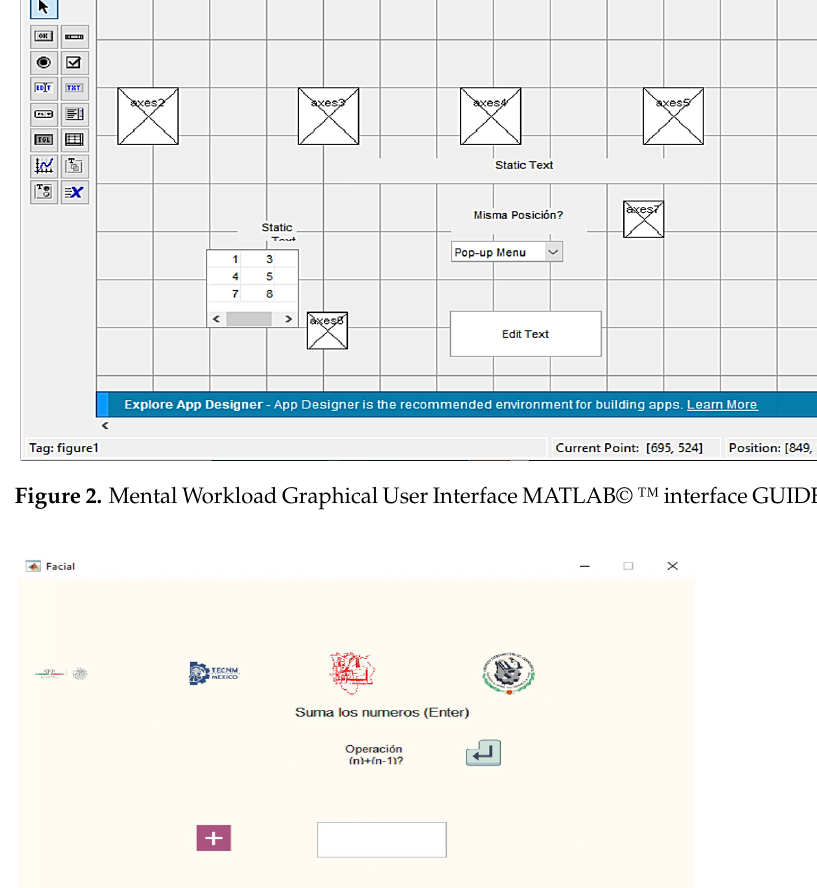
Figure 2. Mental Workload Graphical User Interface MATLAB© ™ interface GUIDE. Source: Au- thors.